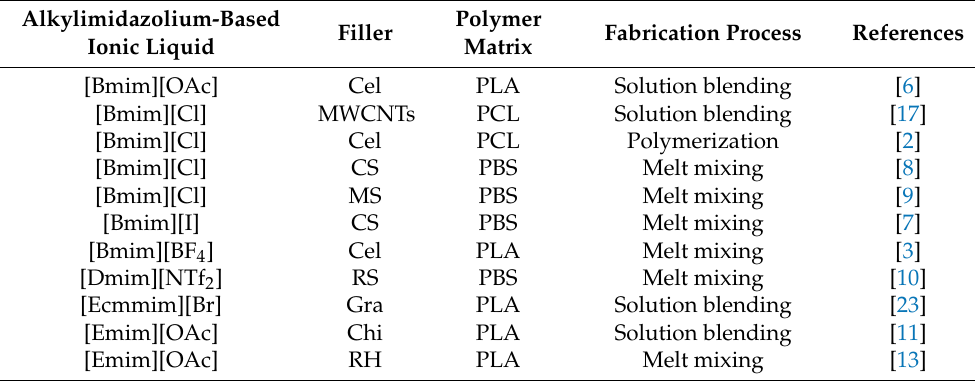
Figure 3. Schematic of the ( a ) protonation, ( b ) alkylation, and ( c ) neutralization reactions for synthesis of alkylimidazolium-based ionic liquids. Table 4. Types of alkylimidazolium-based ionic liquids, fillers, polymer matrices, and fabrication processes of biodegradable polymer